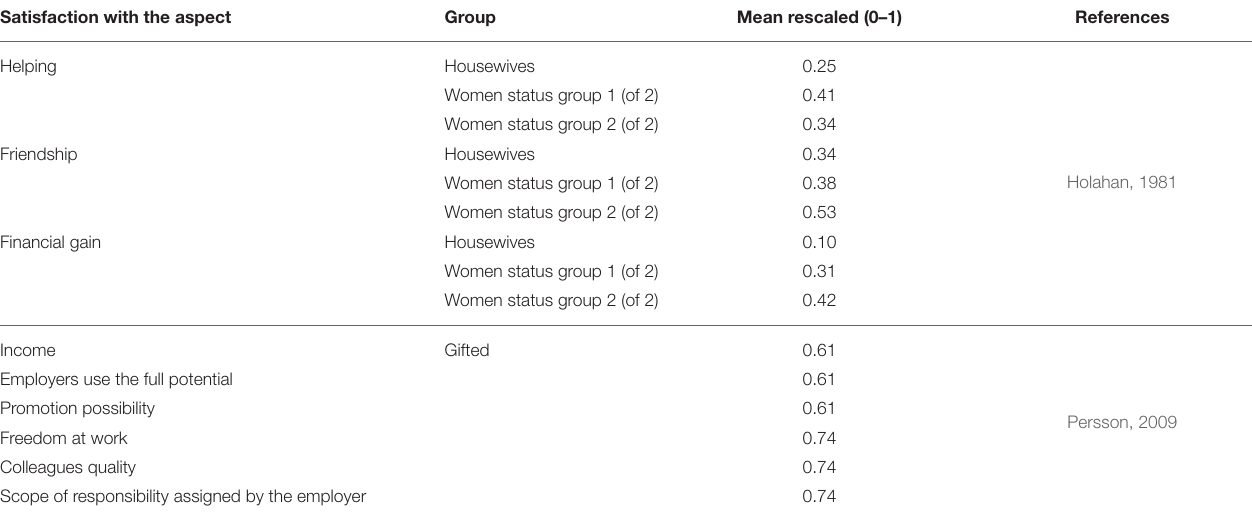
TABLE 9 | Satisfaction with partial aspects of the job. Satisfaction with the